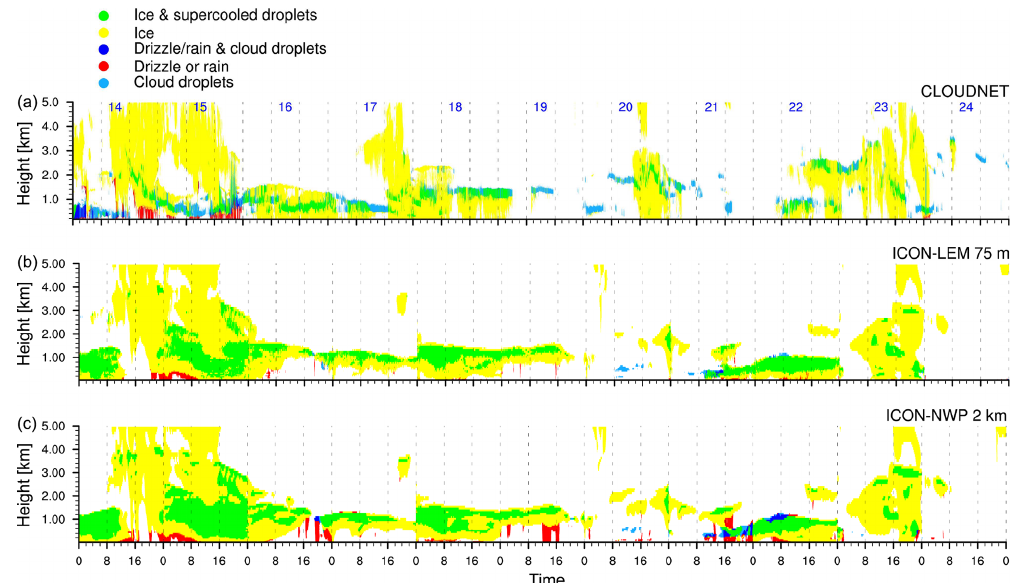
Figure 2. Hydrometeor classification for the whole time series for the observations (a) , the ICON-LEM 75m simulation (b) and the ICON- NWP 2km forcing data (c) .